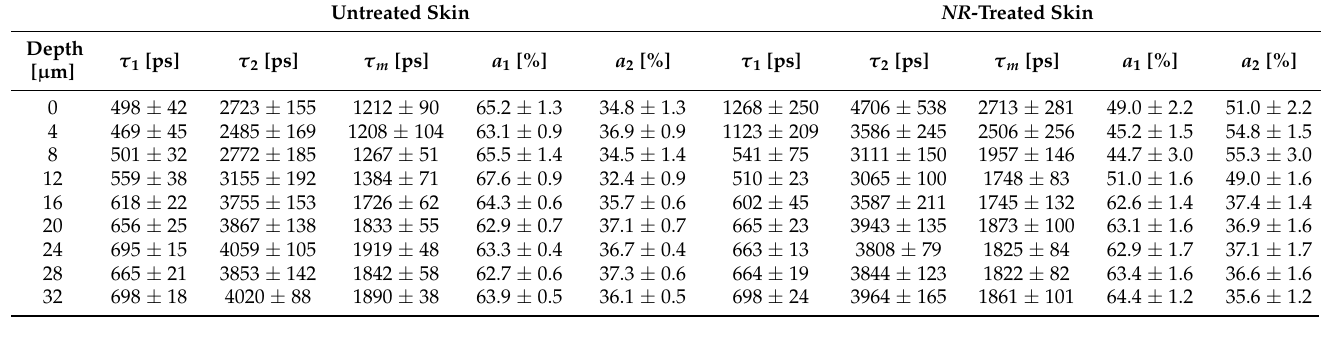
Table 4. TPE-FLIM parameters of untreated and NR -treated skin. Mean ± SEM. N = 6.